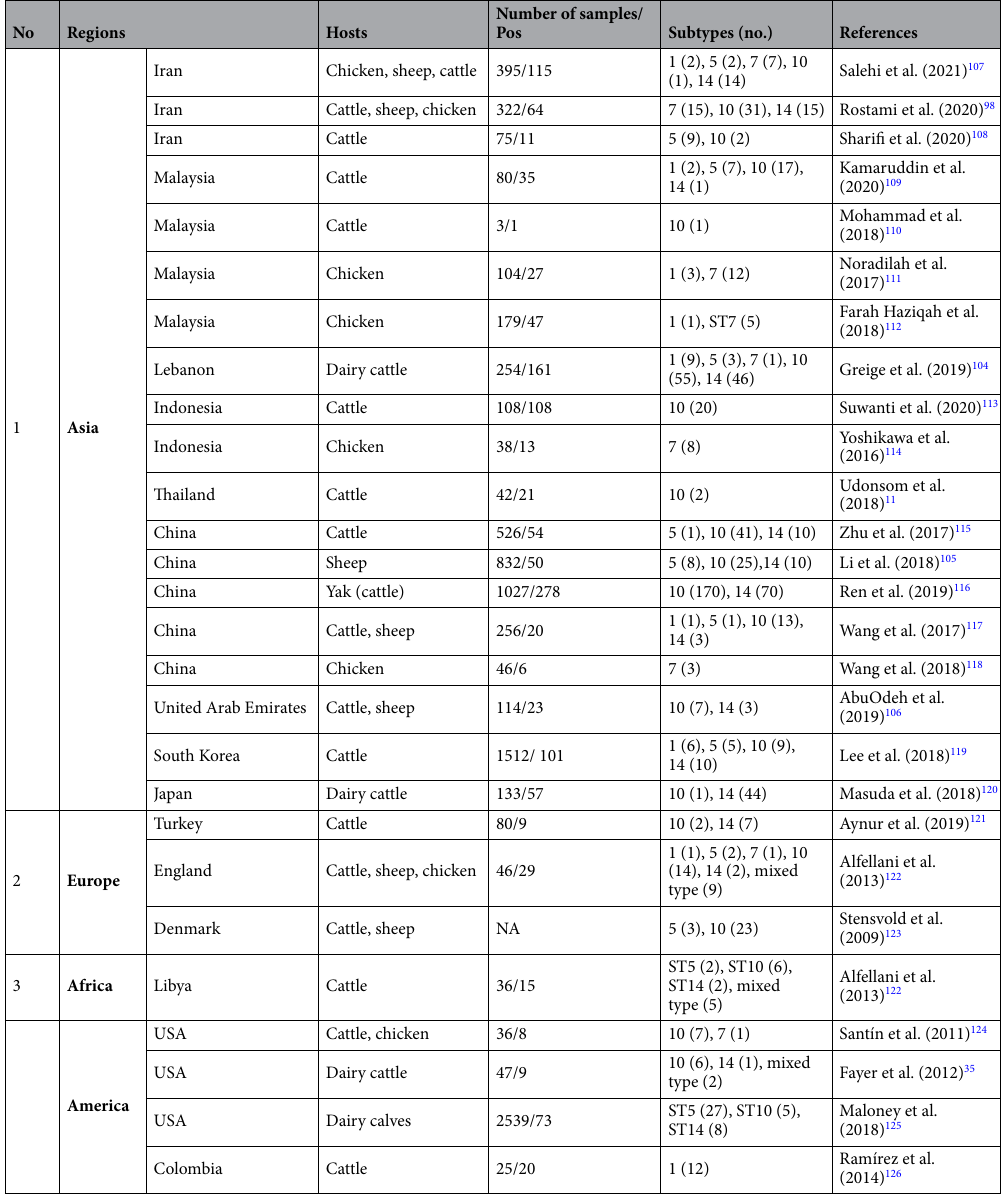
Table 7. A summary of distribution of the subtypes 1, 5, 7, 10, and 14 from selected studied hosts (sheep, cattle, chicken, and horse) in the world. NA: not assigned. This table contains only those studies that amplified and sequenced the “barcoding region” of the SSU rRNA gene of Blastocystis sp. In studies that worked on several hosts, the number of samples and the number of positive samples were justified based on the only selected hosts (cattle, sheep, chicken, and